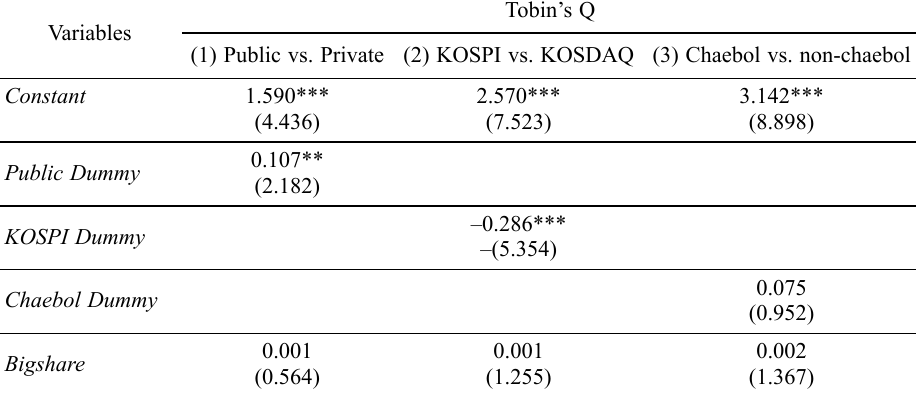
Table 6. Comparisons between public and private offerings, KOSPI and KOSDAQ